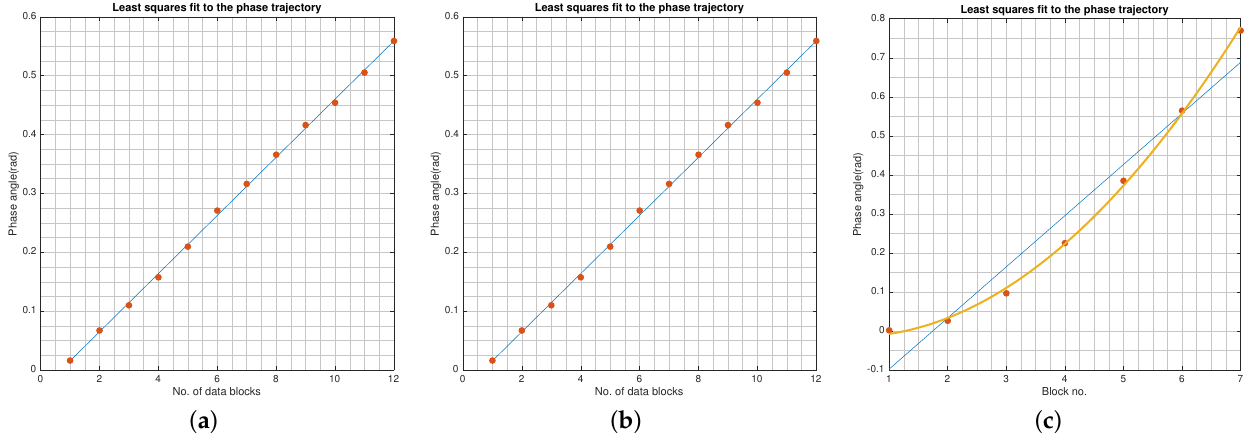
Figure 6. The offset frequency f d is the slope of the phase trajectory θ = 2 π f d t . The least squares fit to the estimated phase values is used to estimate the slope. ˆ f d = 0.0505 with f d = 0.05. This approach works for nonlinear phase trajectory as well. ( a ) SNR = 20 dB, ( b ) SNR = 10 dB, ( c ) Quadratic fit to time varying phase angle. Symbols rotate by 2 π f d T radians over the length of a block. This rotation must be kept to a small fraction of the quadrant that the symbols belong to. For example, in QPSK, each quadrant is π /2 radians. The proper block length is guided by the modality of phase histograms. A unimodal phase histogram with a distinct peak indicates that phase variations remain close to the nominal value, Figure 7a. For large 2 π f d T , either due to large f d or long block length T , the histogram becomes multimodal with no distinct peaks, Figure 7b. Another disadvantage of large f d T is the 2 π phase ambiguity where symbols move around the circle multiple periods.